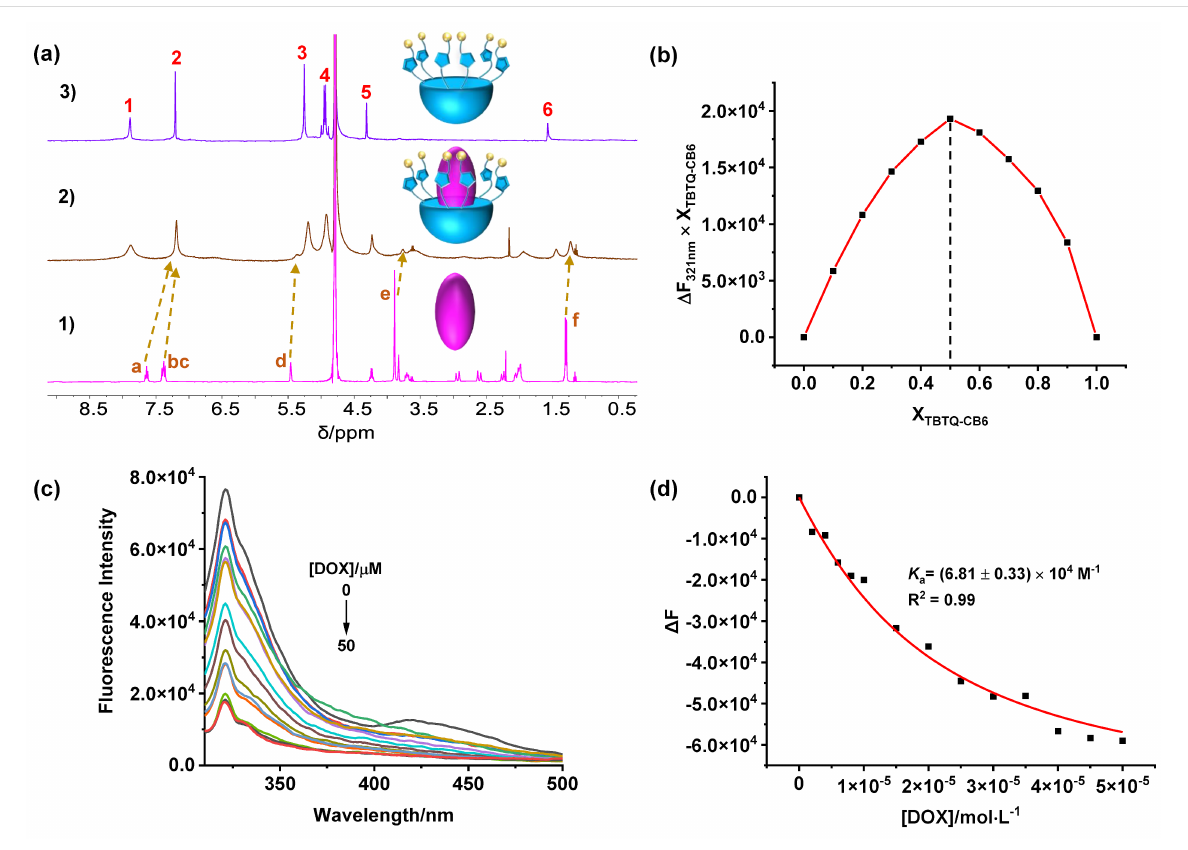
Figure 2: (a) 1 H NMR spectra (400 MHz, D 2 O, 25 °C) of (1) DOX , (2) TBTQ-CB6 and DOX , (3) TBTQ-CB6 with [ TBTQ-CB6 ] = [ DOX ] = 3 mM in each case. (b) Job plot curve of TBTQ-CB6 and DOX by plotting fluorescence changes at 321 nm against the molar fraction of TBTQ-CB6 (X TBTQ-CB6 ). (c) Fluorescence titration spectra of TBTQ-CB6 (10 μ M) with varying concentrations of DOX in water ( λ ex = 290 nm). (d) Plot of Δ F vs [ DOX ] at 321 nm according to (c) (the solid line was obtained from the nonlinear curve